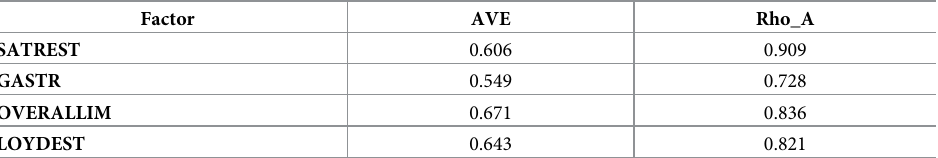
Table 4. Convergent validity.